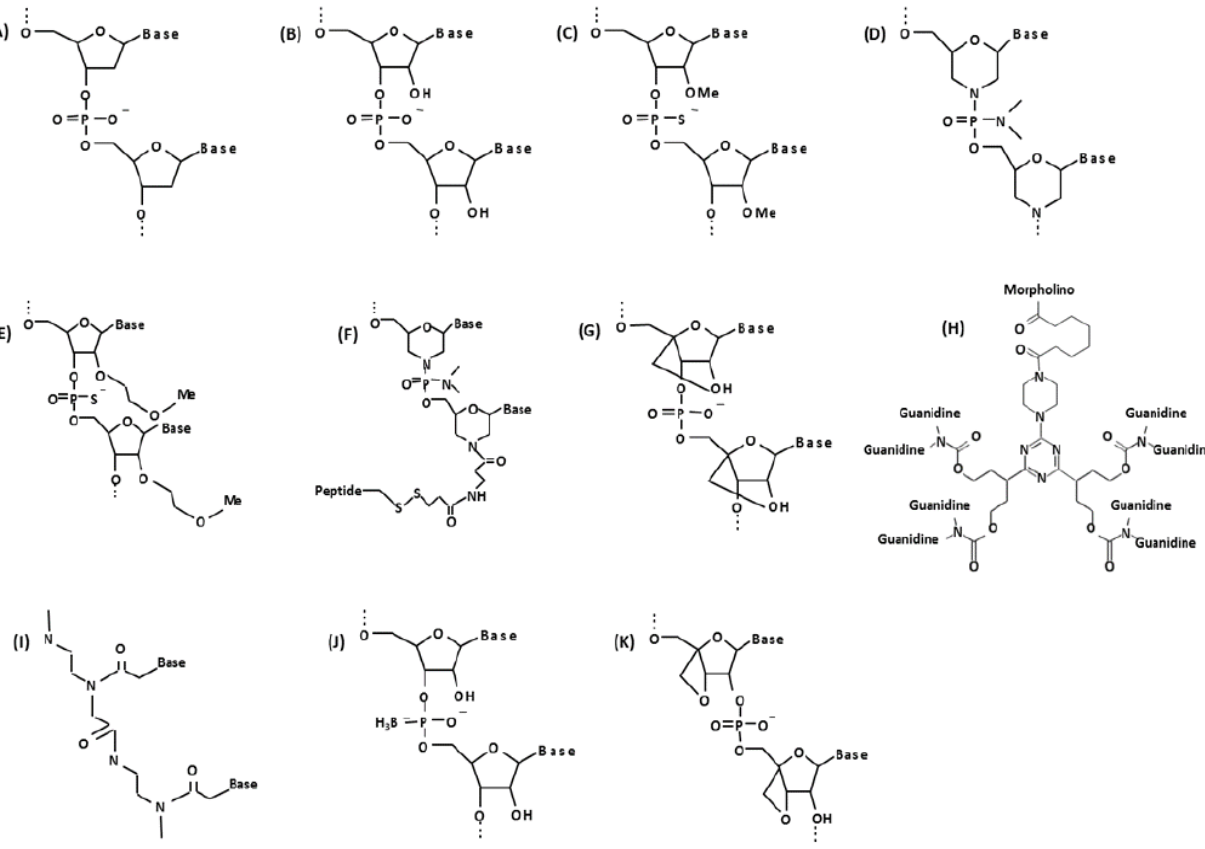
Figure 1. Chemical structure of biological and synthetic oligonucleotides. ( A ) DNA; ( B ) RNA; ( C ) 2'O-methylphosphorothioate (2'O-MePS); ( D ) Morpholino (PMO); ( E ) 2'-methoxyethoxy (2'-MOE); ( F ) PMO with peptide conjugate (PPMO); ( G ) Locked nucleic acid (LNA); ( H ) Vivo-morpholino (vPMO); ( I ) Peptide nucleic acid (PNA); ( J ) Boranophosphate-oligodeoxy-nucleoside (BH3-ODN); ( K ) Oxetane-modified